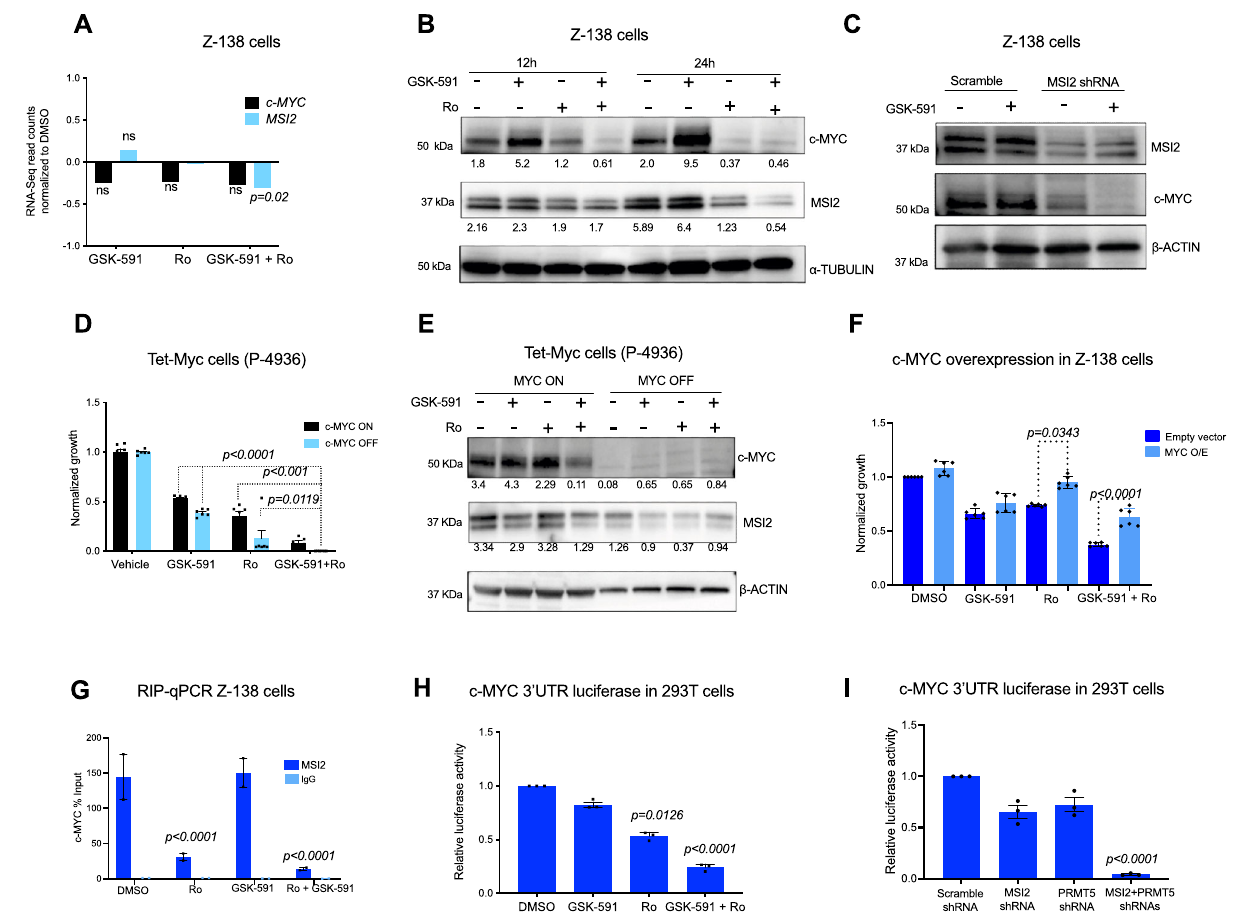
Fig.5|MSI2mediatesPRMT5resistancethroughcontrolofc-MYCtranslation. A mRNA expression of c-MYC and MSI2 from RNA-Seq experiment Fig. 4E, n